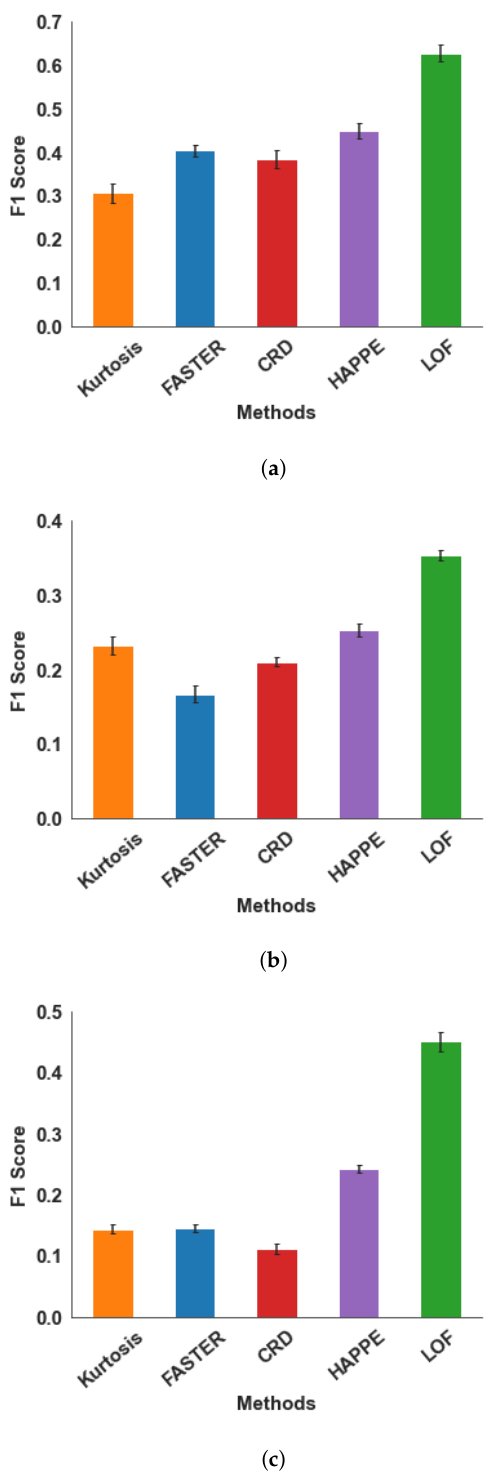
Figure 5. Performance of bad channel detection methods using the 10-fold cross-validation tech- nique on ( a ) Newborn, ( b ) Infant, and ( c ) Adult EEG. The error bars represent the s.e.m. across validation